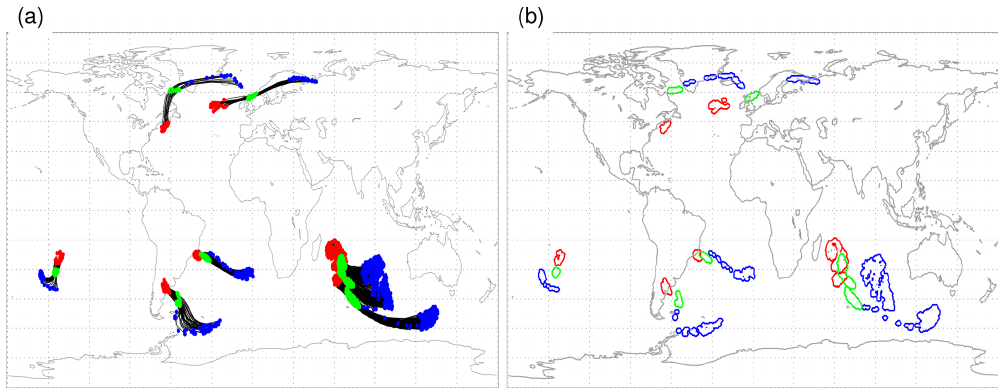
Figure 1. Example of identified WCB trajectories started at 00:00UTC on 15 December 1990 in an ensemble member of HIST. (a) The 48h forward trajectories (black); the positions at times 0h (start of ascent), 24h (during ascent), and 48h (end of ascent) are marked with red, green, and blue dots, respectively. (b) WCB masks, with a 100km blown-up radius, at the same times and with the same colours as in (a) . The three WCB masks at times 0, 24, and 48h, averaged over the whole ERA-Interim and CESM periods and all ensemble members, build the basis for the climatologies in Sects. 3 and 4 (see text for